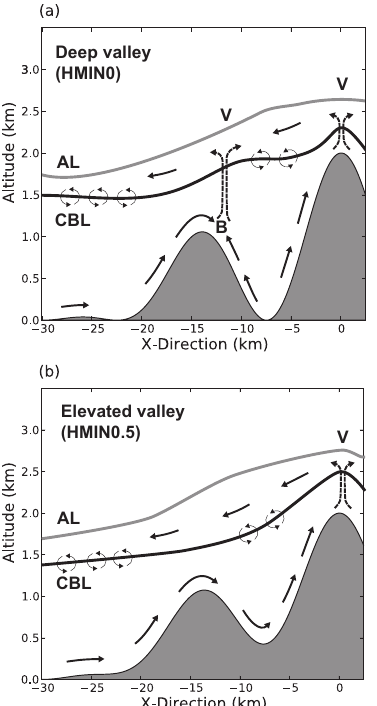
Figure 15. Conceptual diagram of the flow pattern for (a) a deep valley (HMIN0) and (b) an elevated valley (e.g., HMIN0.5) after 6h of simulation. The black and gray solid lines mark the temperature- based CBL and the AL height, respectively. Thick, solid arrows represent the cross-mountain flow, and thin, solid arrows mark the turbulent exchange in the entrainment layer over the foreland and the valley region. Dashed, double-lined arrows indicate the vertical transport through the CBL top as a result of horizontal flow conver- gence. V denotes mountain and advective venting and B indicates flow